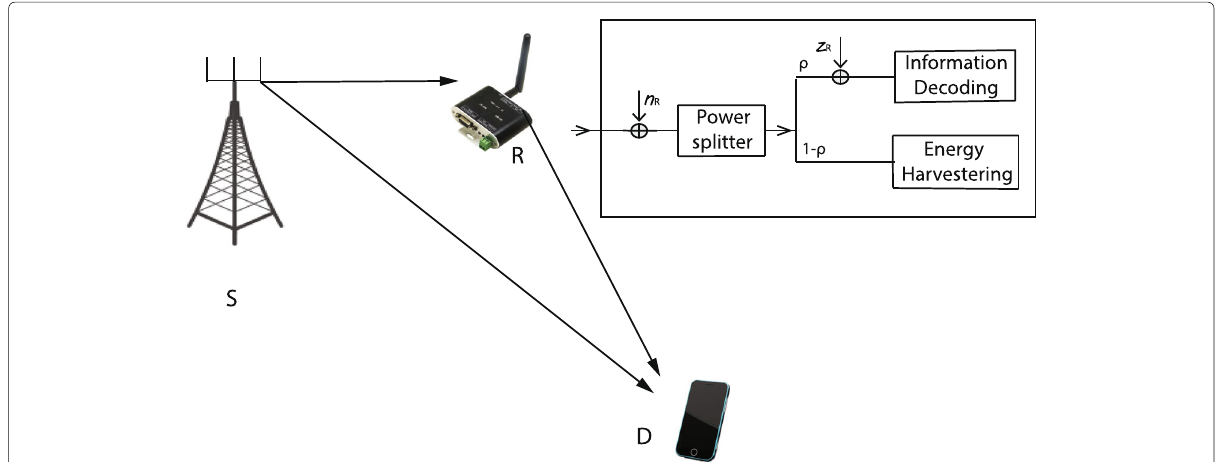
Fig. 1 A system structure for energy harvesting relay-aided cooperative network with a power splitter relay